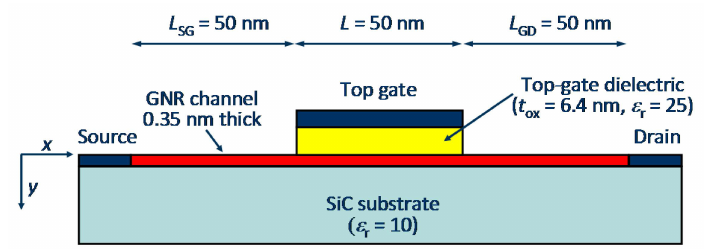
Figure 3. Cross-section (in the x - y plane) of the simulated graphene nanoribbon